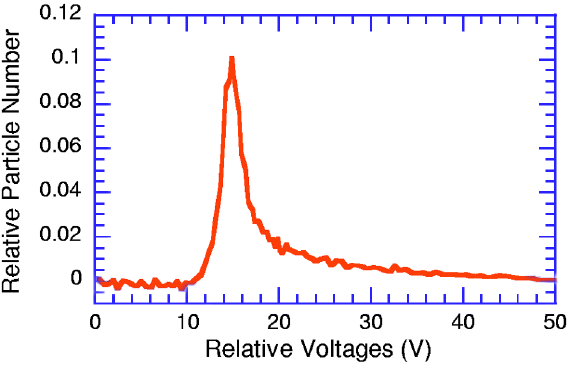
FIG. 3. (Color) One-dimensional model of the energy analyzer.